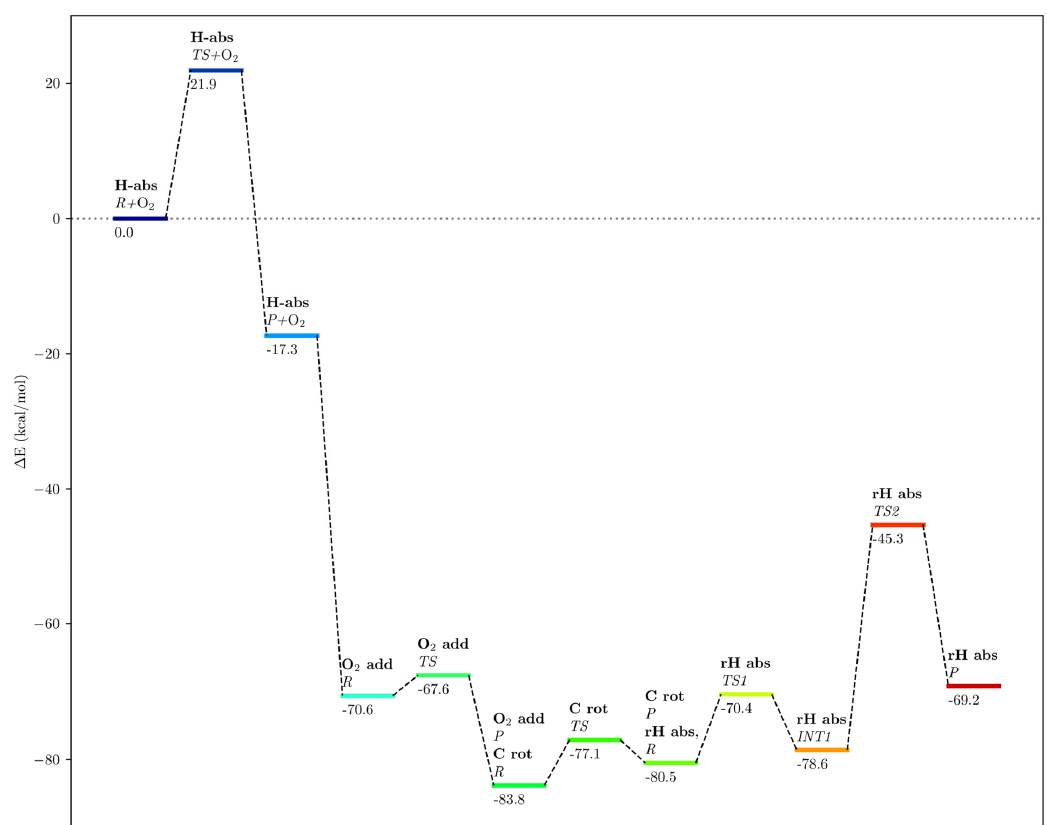
Figure 16. Overall energy scheme of the H 12proS -abstraction, oxygen addition, carbon chain rotation, and retro-hydrogen abstraction steps of the DHA hydroperoxidation mechanism in hALOX12. All energies are in kcal/mol. The zero of energies corresponds to the reactant of the H 12proS abstraction step bound to the solvated enzyme plus an oxygen molecule within the water box whose position has been optimized at 12.1 Å from the substrate’s C 14 .